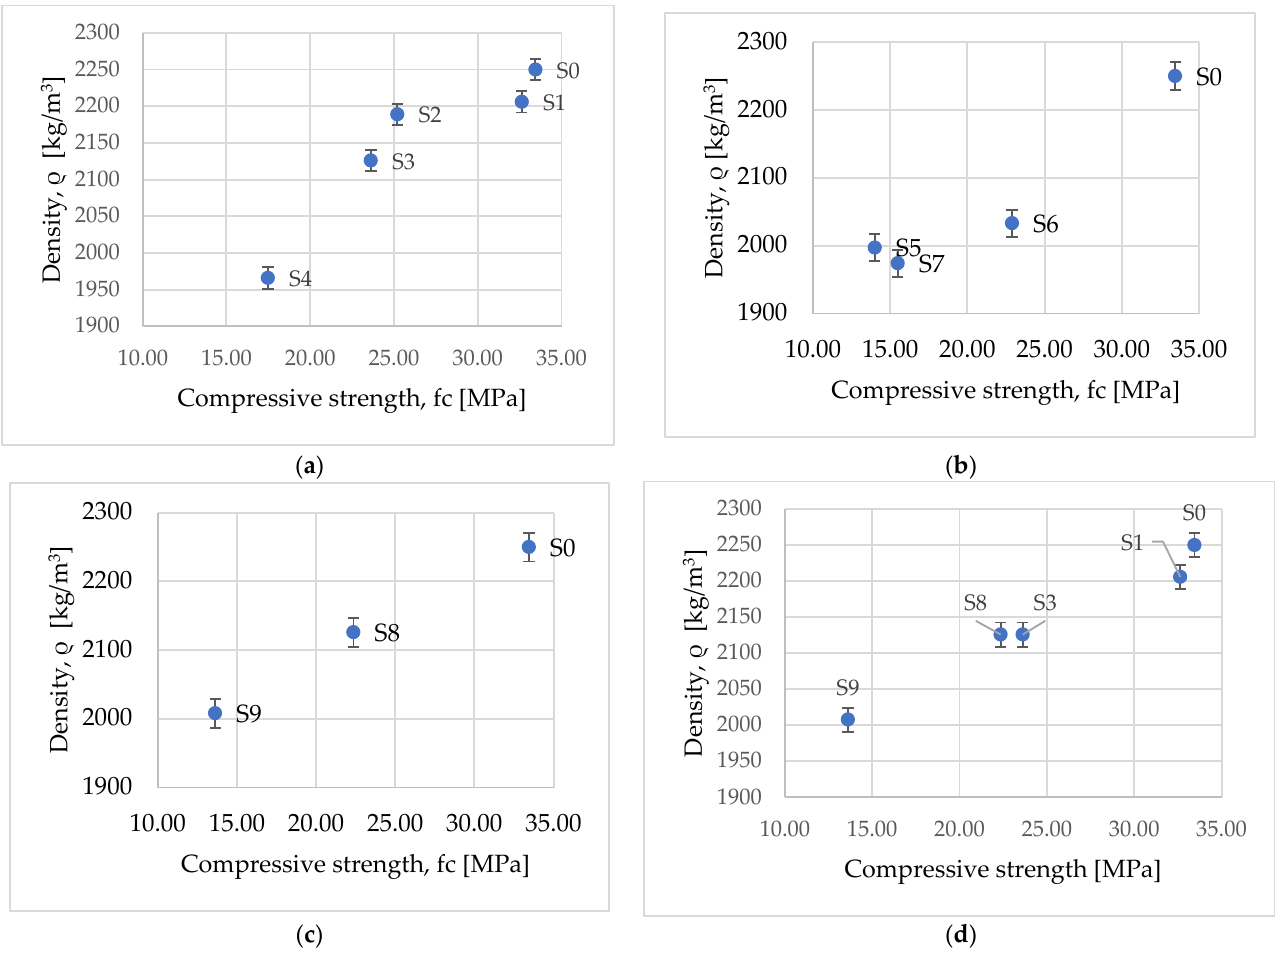
Figure 8. Variation of density versus compressive strength for concrete with waste: ( a ) concrete with waste chopped PET; ( b ) concrete with granular polystyrene; ( c ) concrete with sawdust; ( d ) concrete with waste chopped PET and sawdust.